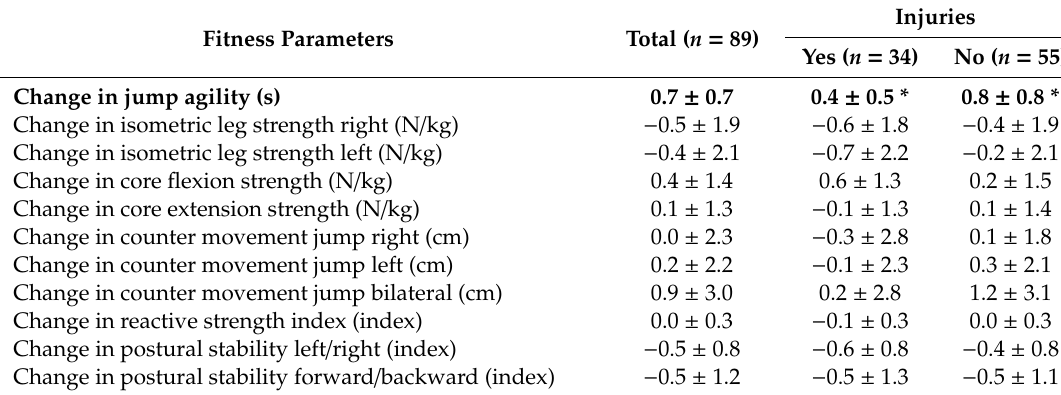
Table 2. Change in fitness parameters for total sample and athletes with and without